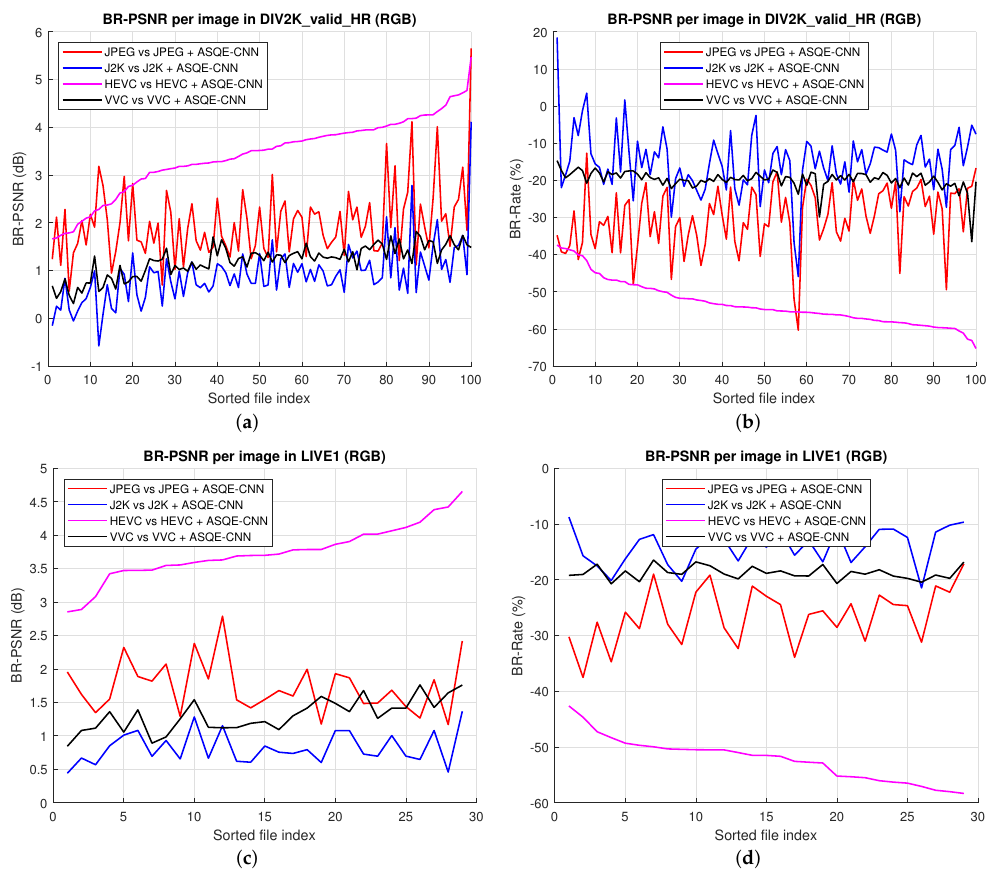
Figure 7. BD-PSNR results for every image in ( a ) DIV2K_valid_HR [52] and ( c ) LIVE1 [54]. BD-rate